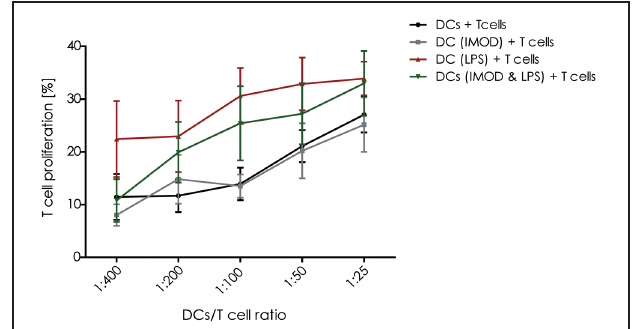
FIGURE 4 | IMOD inhibits DC-induced T cell proliferation. Immature dendritic cells were stimulated with IMOD (concentration 1:800) in the presence and absence of LPS. After 18 h of incubation DCs were washed and cultured with allogenic PBLs (1 × 10 5 ) at different ratios for 5 days. The proliferation of T lymphocytes was assessed by overnight BrdU incorporation. The results are representative of independent experiments obtained from three